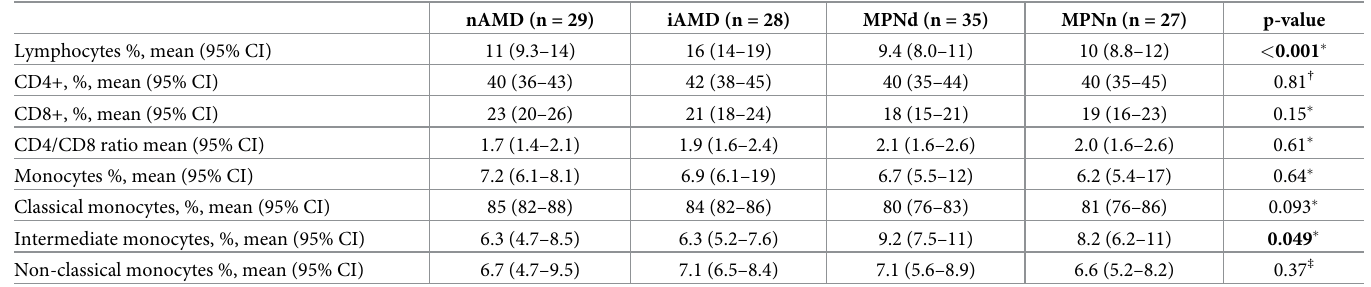
Table 2. Mean percentages of leukocytes in patients with nAMD, iAMD, MPNd, and MPNn.